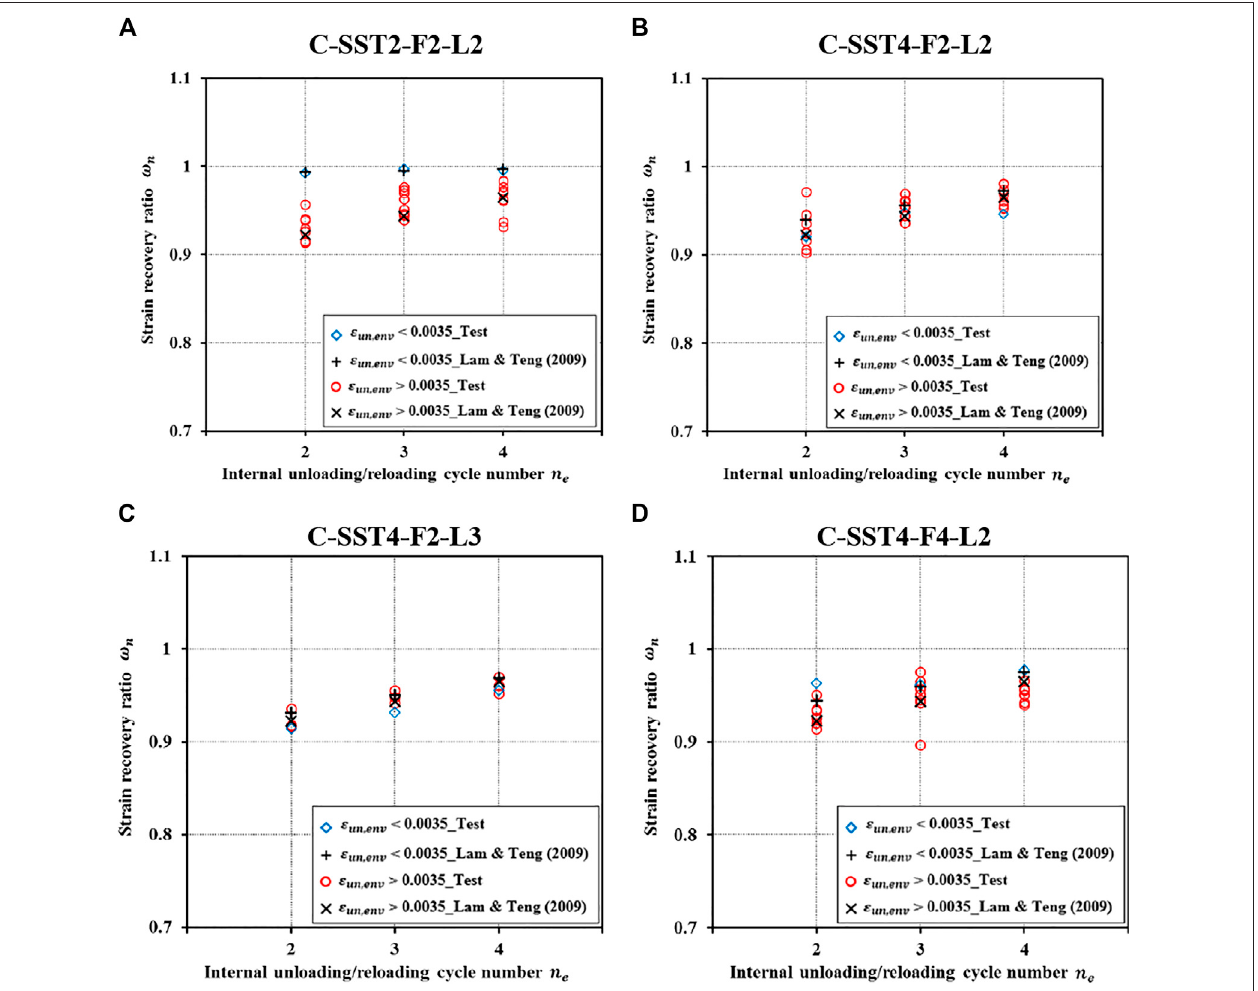
FIGURE 11 | Comparisons of strain recovery ratios of internal cycles ω n . (A) C-SST2-F2-L2. (B) C-SST4-F2-L2. (C) C-SST4-F2-L3. (D) C-SST4-F4-L2.